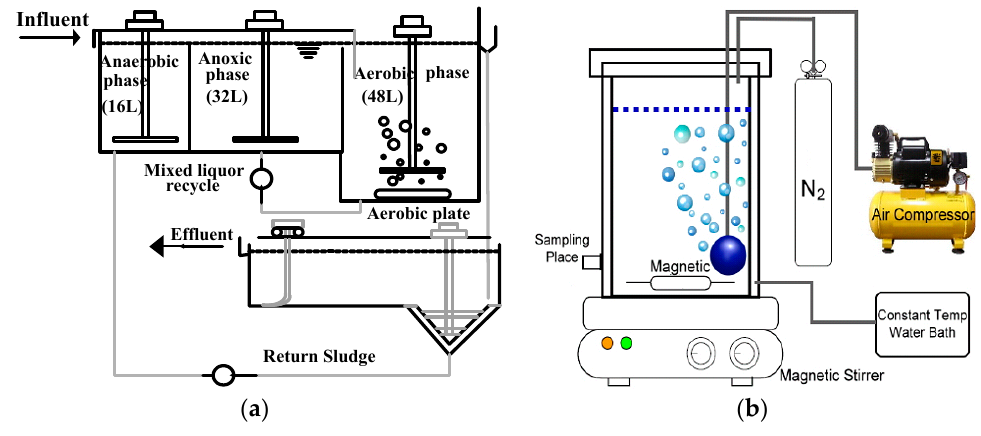
Table 1. National Chi Nan University (NCNU) wastewater treatment plant operating parameters.